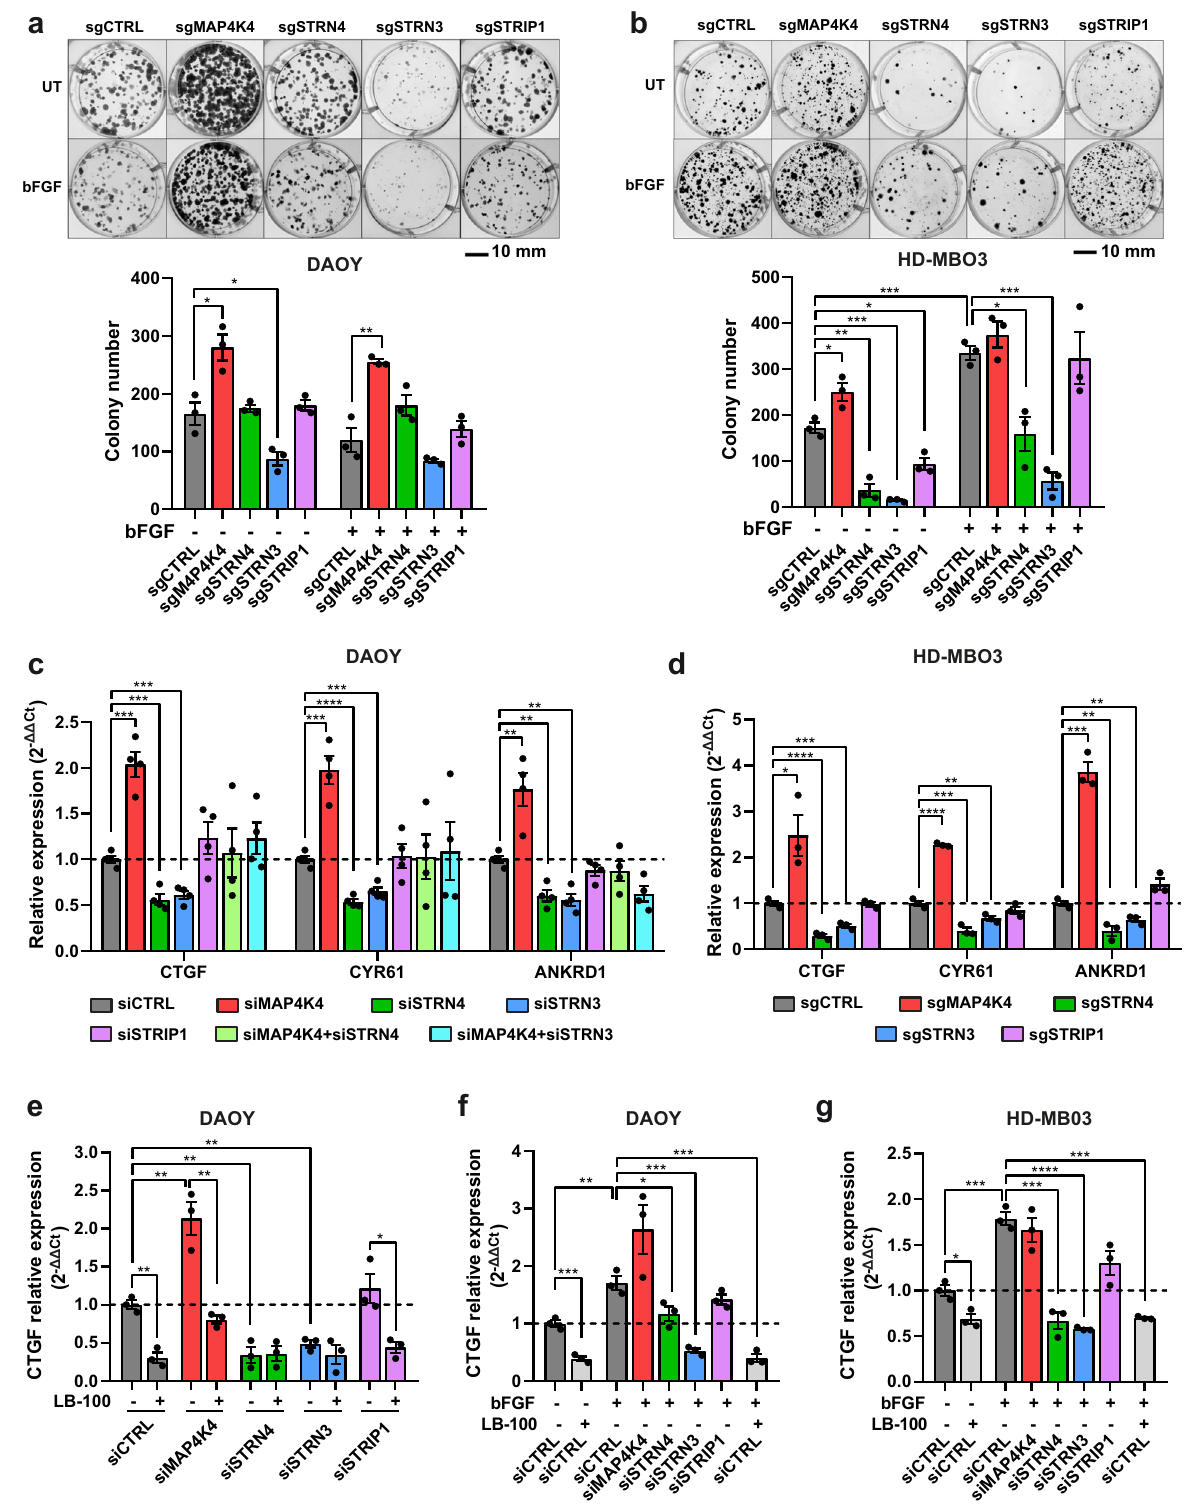
(Fig. 6g). We observed no increase in VASP S157 phosphorylation when MAP4K4 is immunoprecipitated from STRN3-depleted cells, suggesting that STRN3 is necessary to either activate MAP4K4 or to couple it to the VASP protein (Fig. 6g). To test the implication of VASP in bFGF-induced invasiveness in MB cells, we assessed siRNA-depletion of VASP using the SIA (Fig. S9F, G). We found